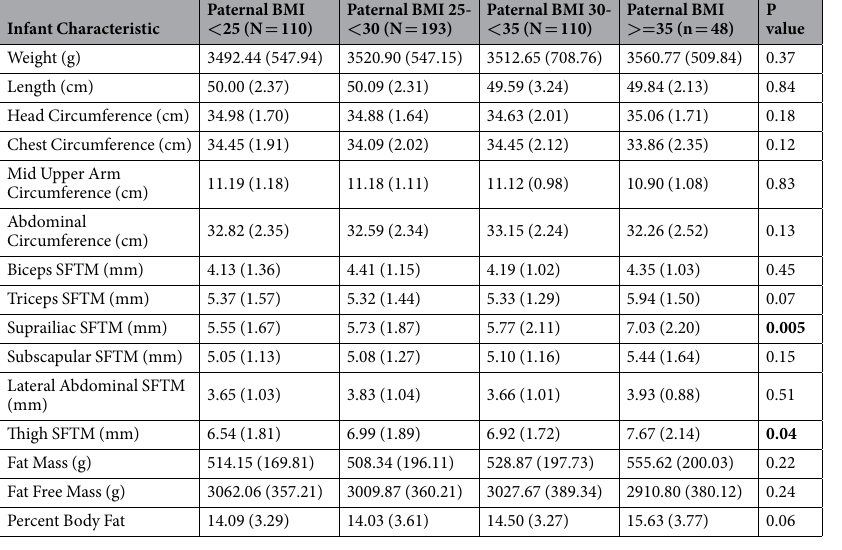
Table 4. Associations between infant morphology and paternal body mass index category from participants in the Standard Care Group. Values are mean (SD). * P-value from global test for effect of paternal BMI category. Results have been adjusted for maternal weight, height, BMI category, gestational weight gain, gestational diabetes, smoking status, socio-economic status, gestational age at birth and infant